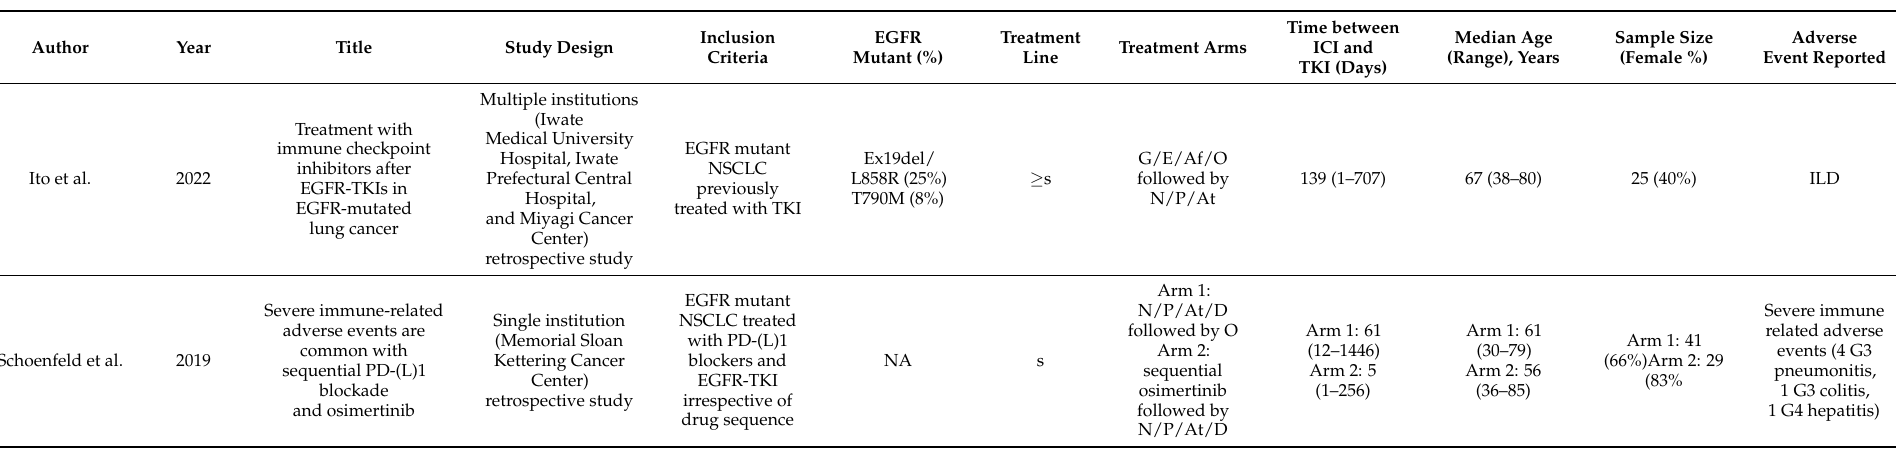
Table 2. Summary of included retrospective